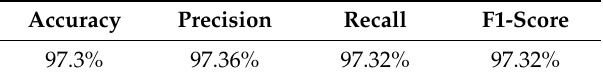
Table 4. The score of the proposed classification model.